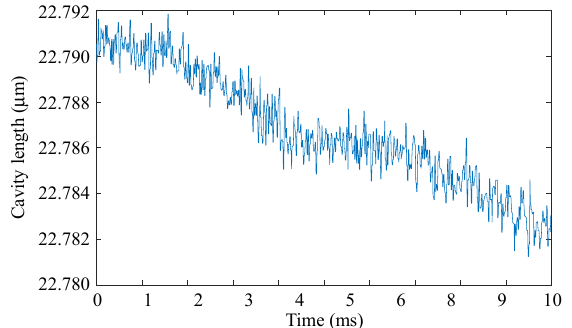
Fig. 13 Plot of cavity length measurements versus